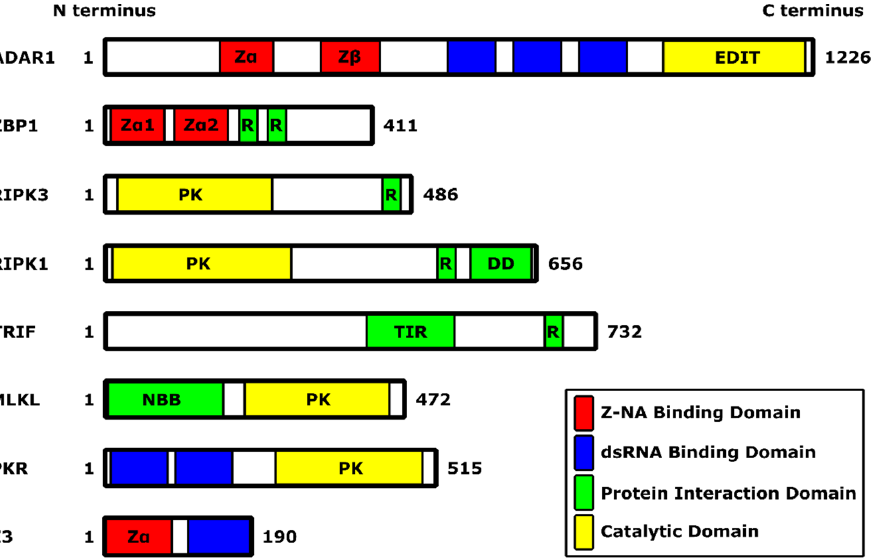
Figure 3. Summary schematic of functional domains present in proteins described in this review. Types of domains are indicated according to the legend. Digits indicate the first and last amino acid residue. For roles and functions of the particular protein, see the main text. Abbreviations used in this figure include: DD: death domain; EDIT: adenine-to-inosine editase; NBB: N-terminal bundle and brace; PK: protein kinase; R: receptor-interacting protein (RIP) homotypic interaction motif (RHIM); TIR: Toll/interleukin-1 receptor. Domains are depicted in